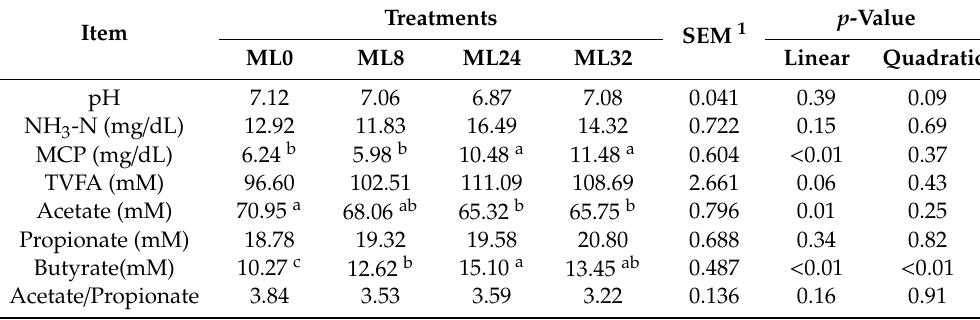
Table 4. E ff ects of inclusive ML treatments on the rumen fermentation of